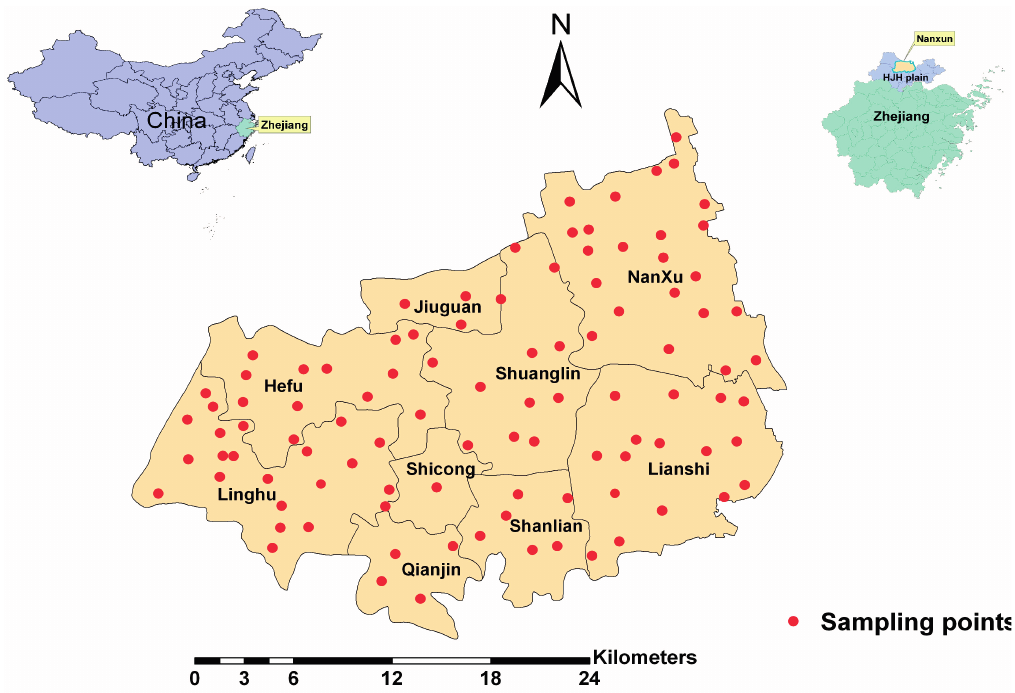
Figure 1. Location of the study area and sample